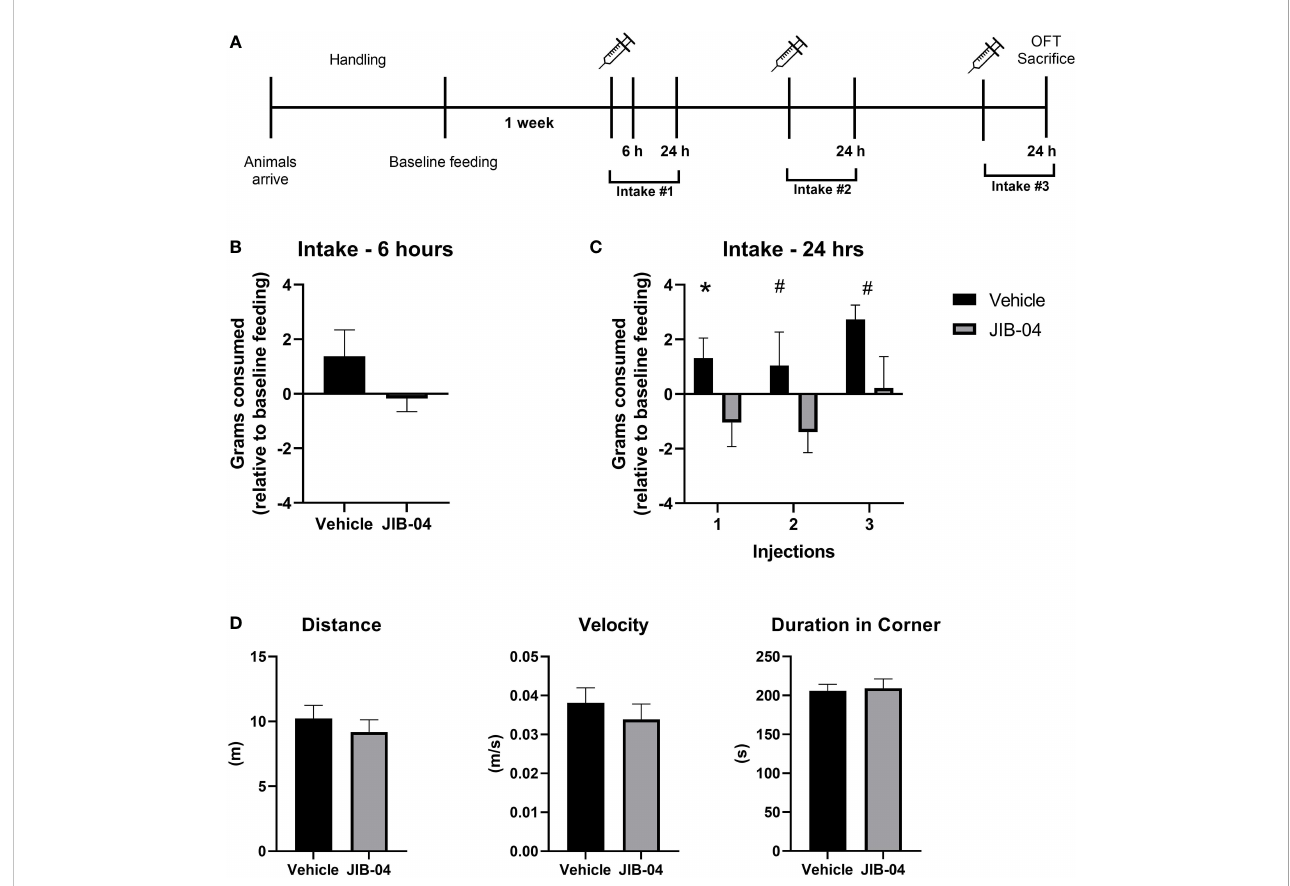
FIGURE 4 JIB-04 administration inhibits feeding behavior. (A) Experimental timeline. Naïve adult female Wistar rats underwent a period of acclimation and handling. Rats were housed individually for 24-hours to collect baseline feeding data. The following week, rats were injected (IP) with JIB-04 or vehicle solution, every-other day for a total of three treatments. Food intake for 24-hours post administration was compared to the baseline feeding measurement of each speci fi c rat. 6 hours after the fi rst injection, intake was measured in one cohort of rats. 24-hours after the fi nal administration, rats were assessed in a standard Open Field Test and then sacri fi ced. (B) Food intake (grams of chow) 6-hours after fi rst injection. The intake of individual rats was compared to their individual baseline intake. n=5 per group. (C) Food intake (grams of chow) was measured 24-hours after each injection (1 – 3). The intake of individual rats was compared to their individual baseline intake. n= 13 per group. (D) At the end of the experiment, rats were exposed to the Open Field test (OFT). The parameter of distance (meter travelled) and velocity (m/s) are measurements of locomotion, and duration in corner measures that the time spend in any of the 4 corners, compared to the center of the arena. n= 13 per group. Data are presented as mean ± SEM, and signi fi cant effects between groups are indicated as # P < 0.1, P *<0.05 using an unpaired